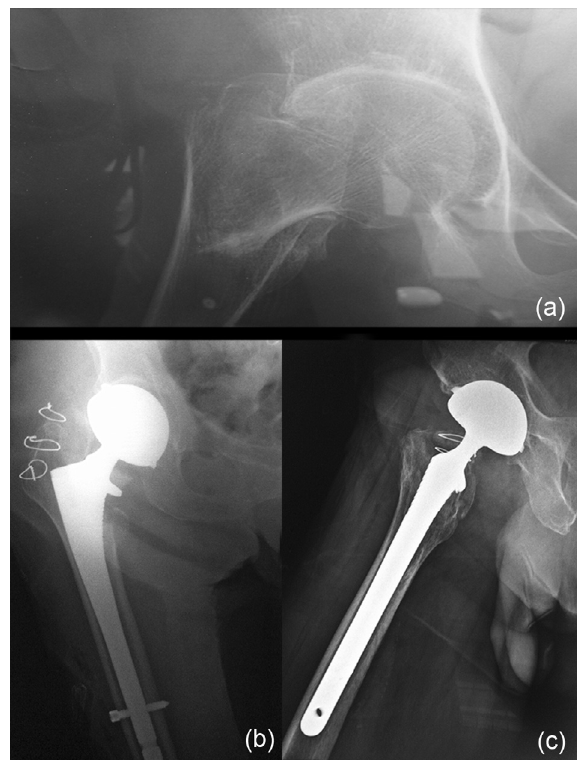
Figure 8. (a) ECTF right hip, (b) cementless stem with distal locking – post-op front view, (c) post-op lateral